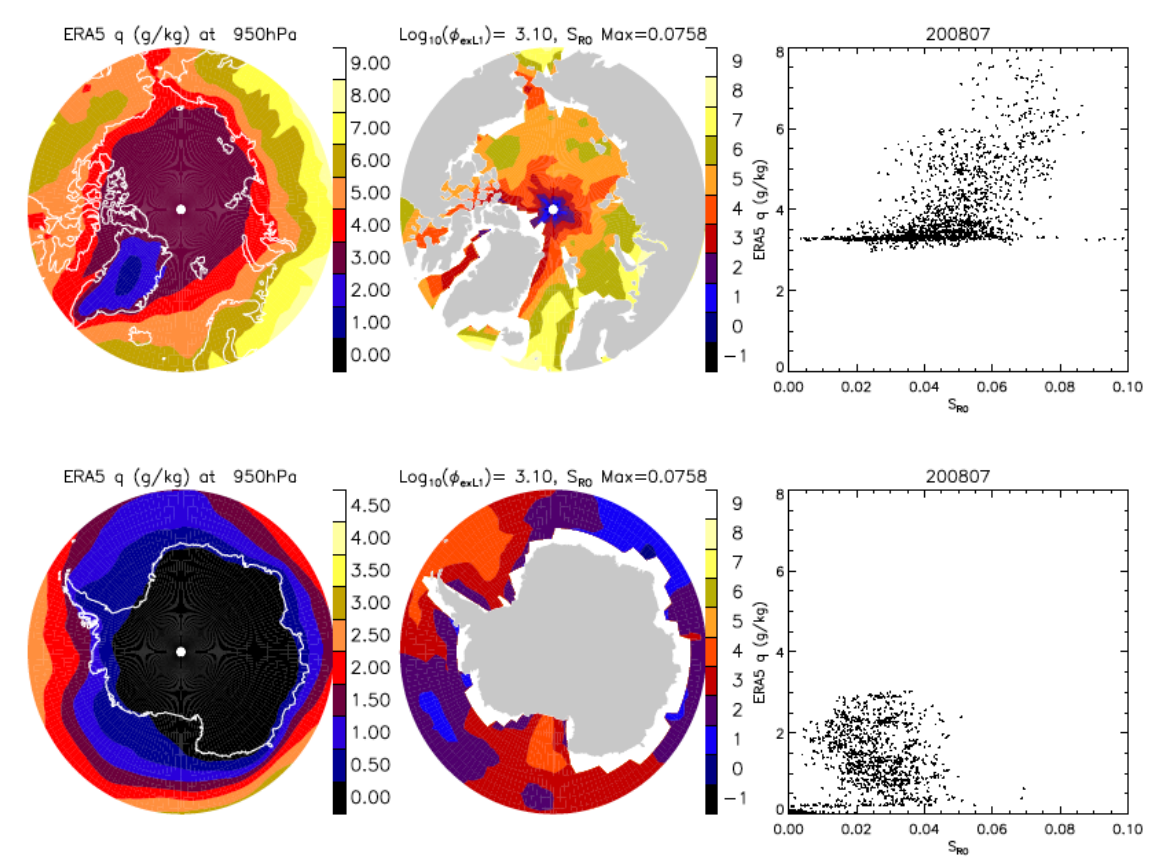
Figure 11. As in Figure 9 but for correlation between the 950 hPa ERA5 q and the COSMIC-1 S RO at Log 10 ( f exL1 ) = 3.10 from July 2008 for the Arctic (top panels) and the Antarctic (bottom panels). The data from latitudes of 60° poleward are used in these comparisons.